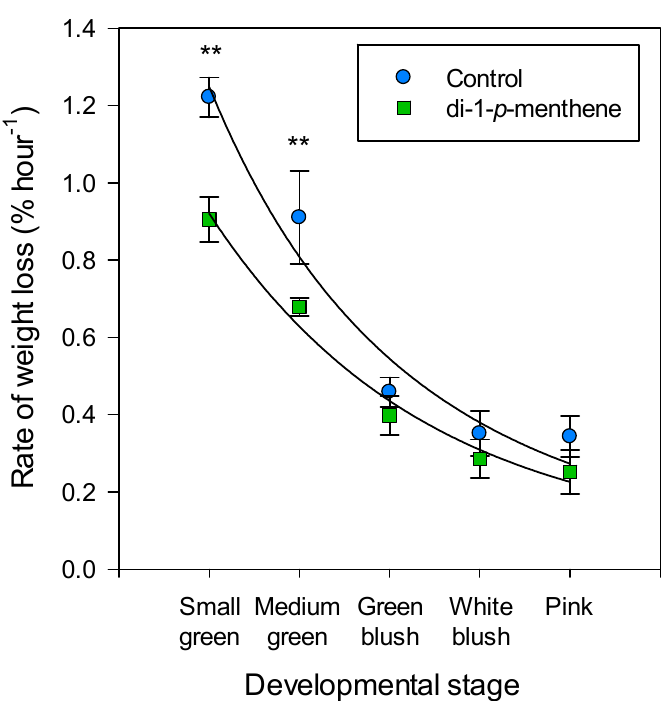
Figure 5. “Cascade Delight” fruit transpiration at the small-green, medium-green, green-blush, white-blush and pink developmental stages after treatment with dH 2 O or 1% di-1- p -menthene. Fruit were held at 20 ◦ C and 60% RH and weighed at 4–6 h intervals over 24 h. Data are expressed as means ± s.e.m., n = 6, ** p < 0.01.